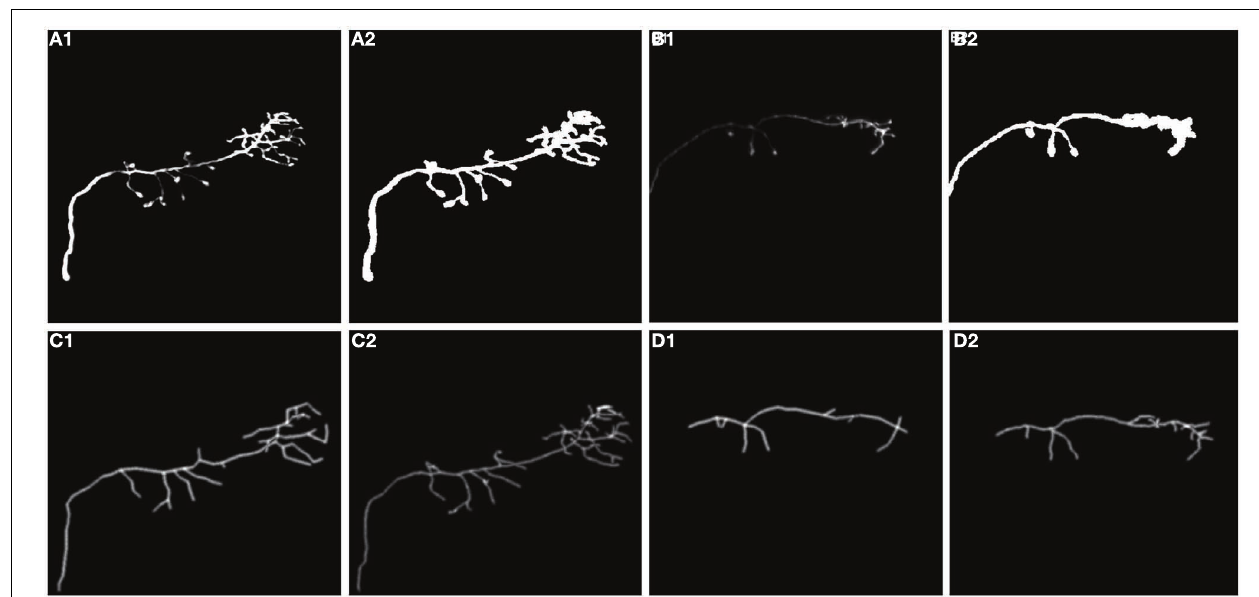
Table 1 |Values of similarity factor type 1 (S1) and 2 (S2), number of end points for reconstructed topology/ground truth (EP), length in voxels of reconstructed topology/ground truth (L), precision (p), recall (r), and accuracy (a) in detecting branches for olfactory projection fibers OP1 and OP3. OP1 OP3 S1 0.4136 0.64 S2 0.6696 0.6543 EP r./g. t. 20/49 16/14 L r./g. t.